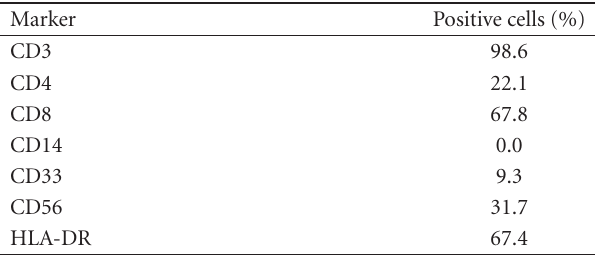
Table 1: Characterization of CIK cells.